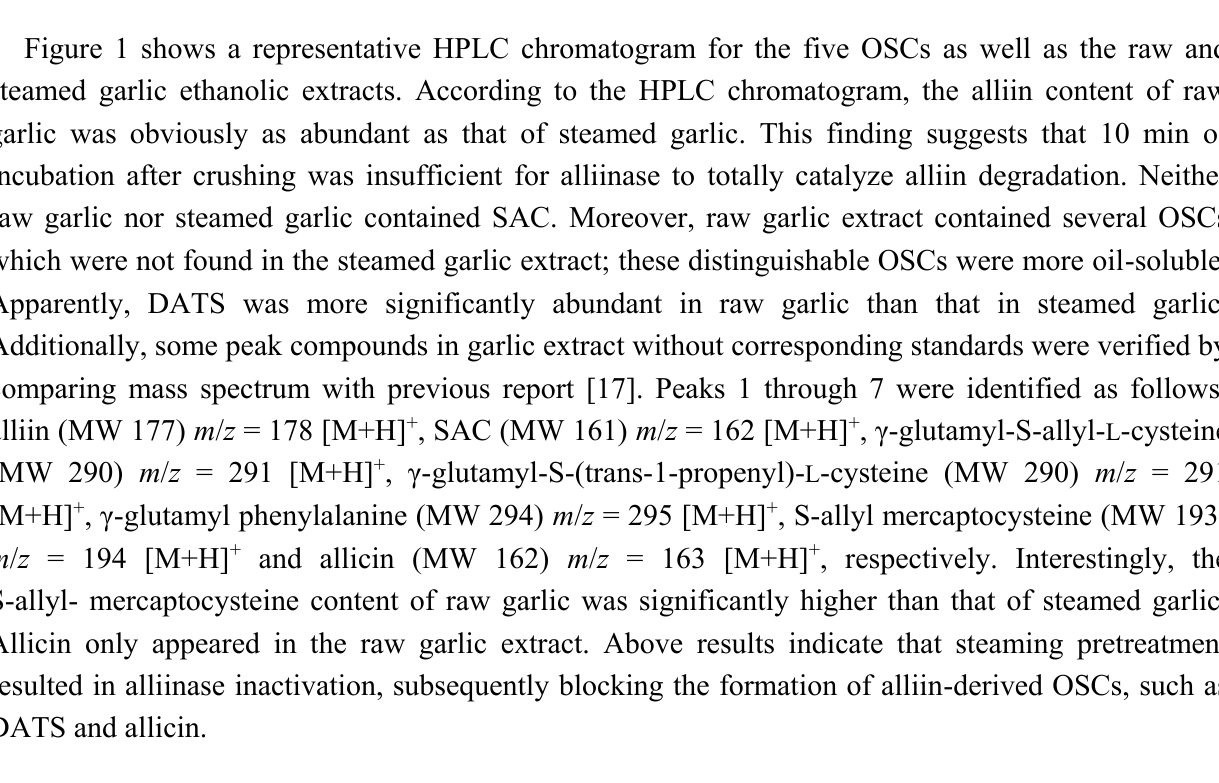
Figure 1. Representative HPLC chromatogram of selected organosulfur standards ( A );